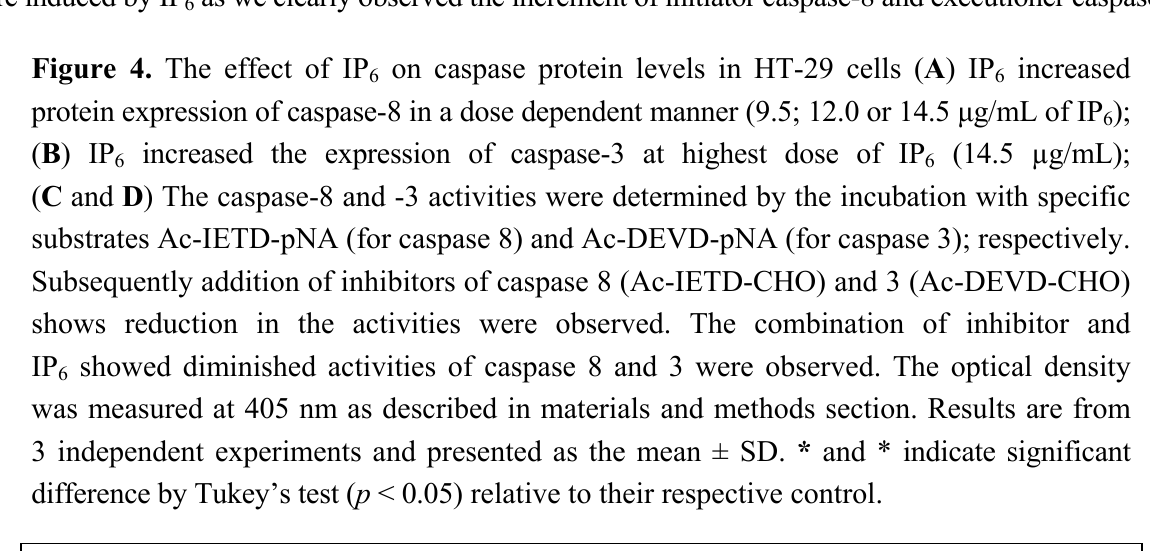
mRNA and protein levels of caspases after incubation of IP in HT-29 cells and activation of caspases 6 were induced by IP as we clearly observed the increment of initiator caspase-8 and executioner caspase-3. 6 Figure 4. The effect of IP on caspase protein levels in HT-29 cells ( A ) IP increased 6 6 protein expression of caspase-8 in a dose dependent manner (9.5; 12.0 or 14.5 μg/mL of IP ); 6 ( B ) IP increased the expression of caspase-3 at highest dose of IP (14.5 µg/mL); 6 6 ( C and D ) The caspase-8 and -3 activities were determined by the incubation with specific substrates Ac-IETD-pNA (for caspase 8) and Ac-DEVD-pNA (for caspase 3);